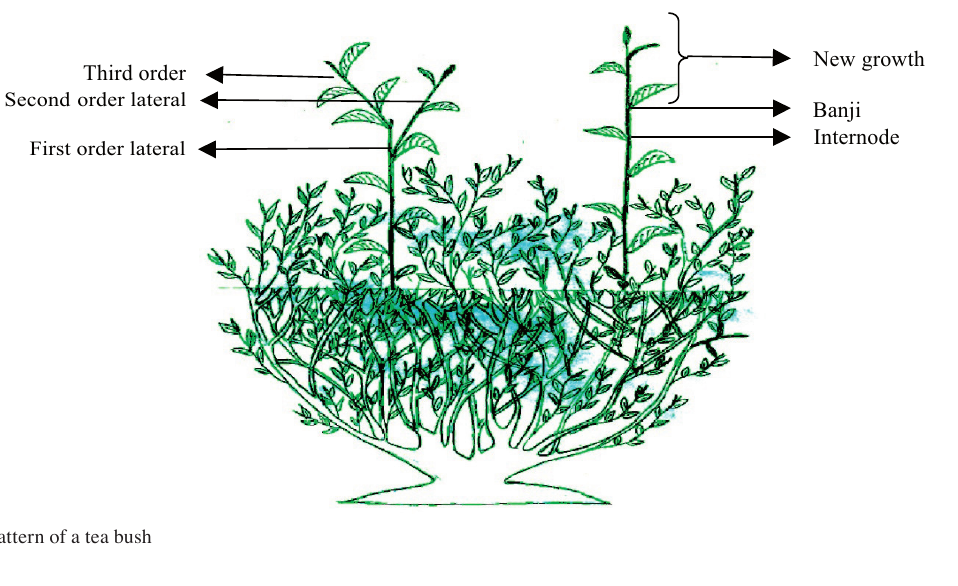
Fig. 2: Branching pattern of a tea bush